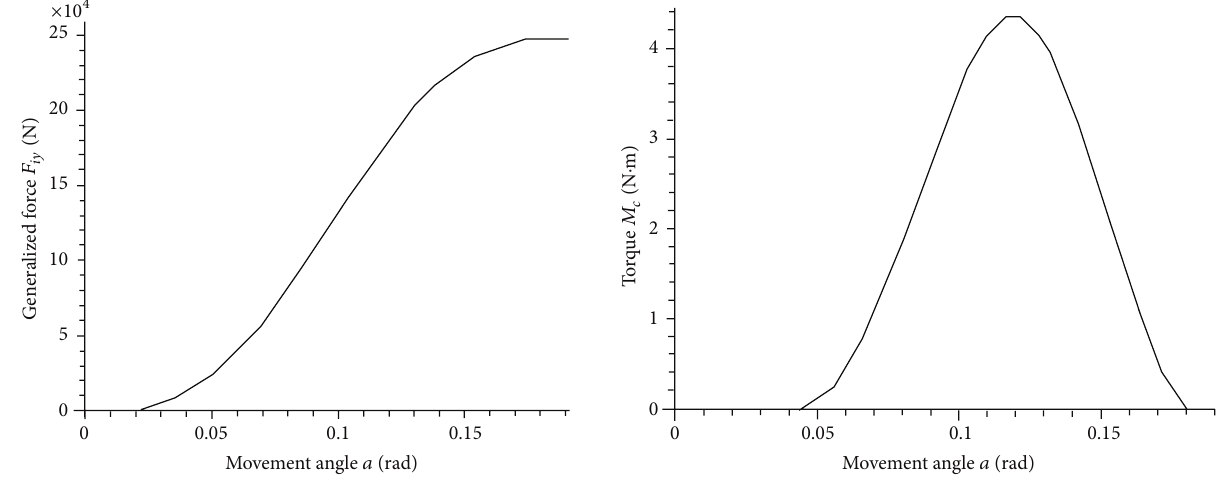
Figure 7: The changing curves of the main generalized force components.